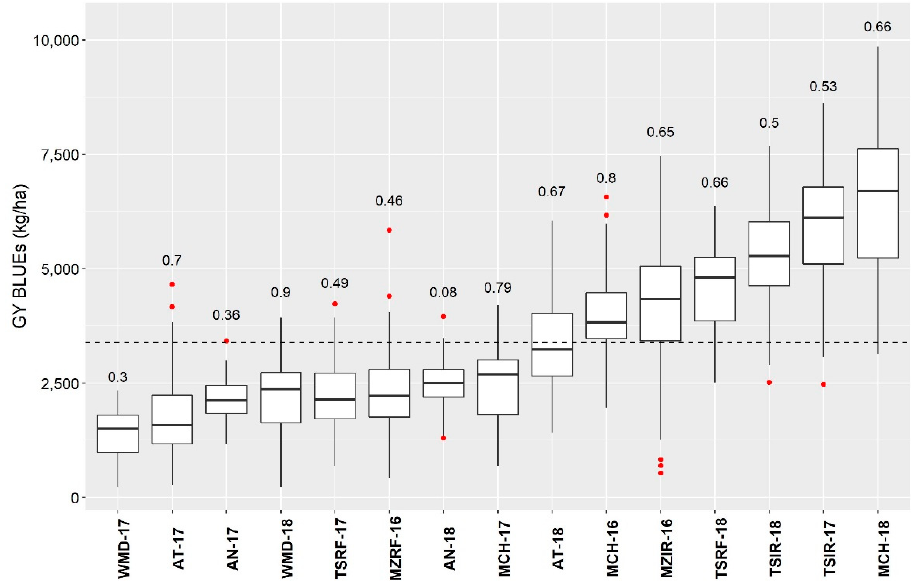
Figure 1. Boxplot of best linear unbiased estimations (BLUEs) and heritability for grain yield (GY) of durum wheat genotypes in the 15 environments included in the stability analysis. The dashed horizontal line represents the grand mean across all environments. The number above each boxplot represents the heritability in that environment and the red dots represent the outliers.